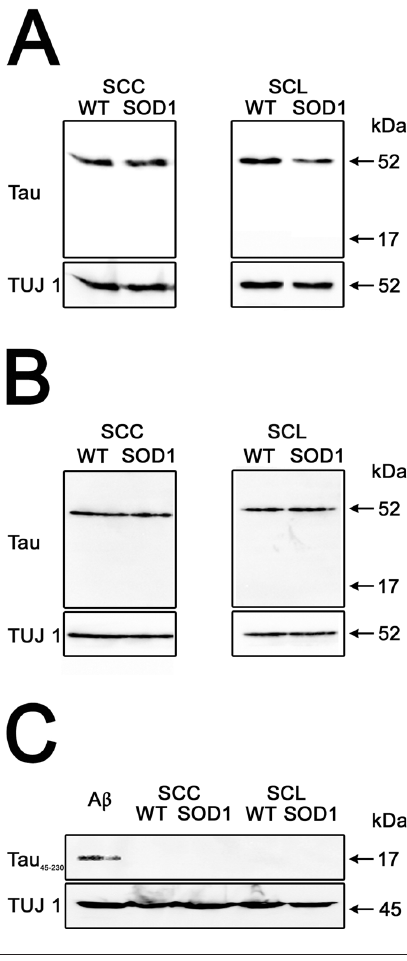
was not detected in the Figure 5. Tau 45-230 spinal cord of SOD1 transgenic mice. (AC) Western blot analysis of cervical (SCC) and lumbar (SCL) spinal cord samples from wild-type (WT) and SOD1 transgenic (SOD1) mice obtained 10 and 17 wks after birth reacted with tau (clone tau5) (A and B) and tau (C) antibodies. 45-230